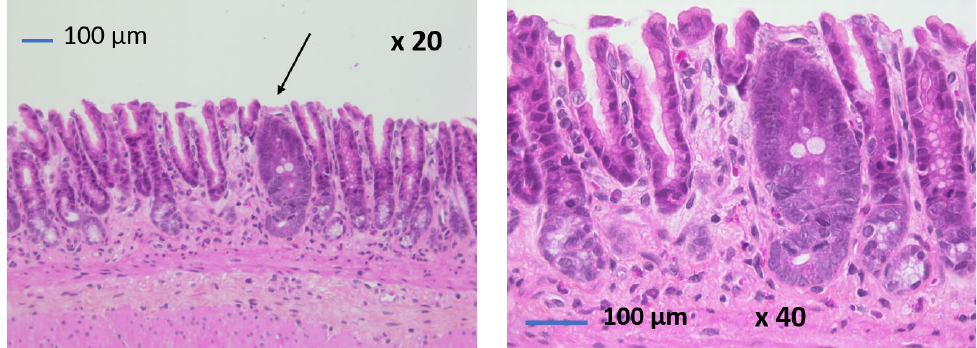
Figure 4. Antral intestinal metaplasia in one sleeve gastrectomy rat at 24 weeks postoperatively ( × 20 and ×